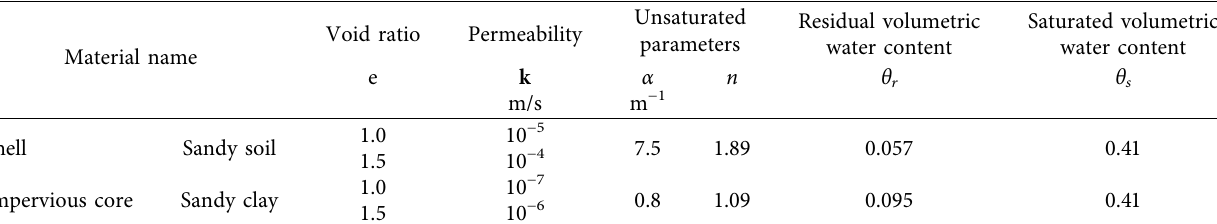
Table 2: Permeability parameters of soils.